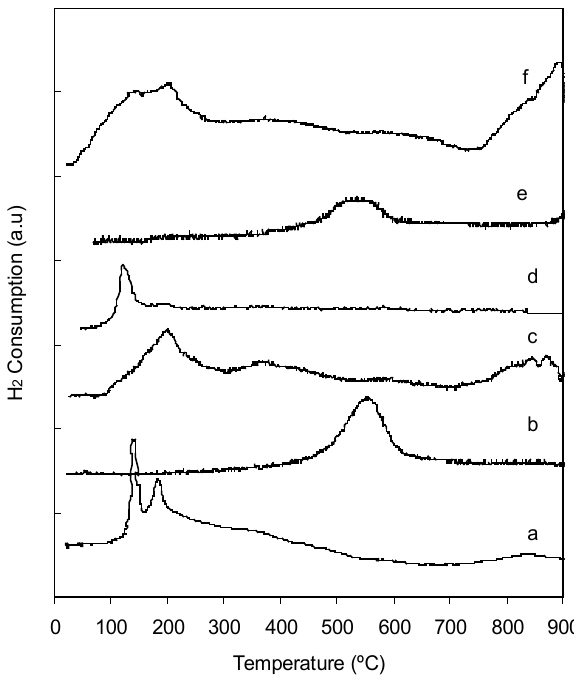
Figure 2: TPR profiles of: a) RhCli-Mor, b) CoCli-Mor, c) RhCoCli-Mor d) RhCli, e) CoCli, f)